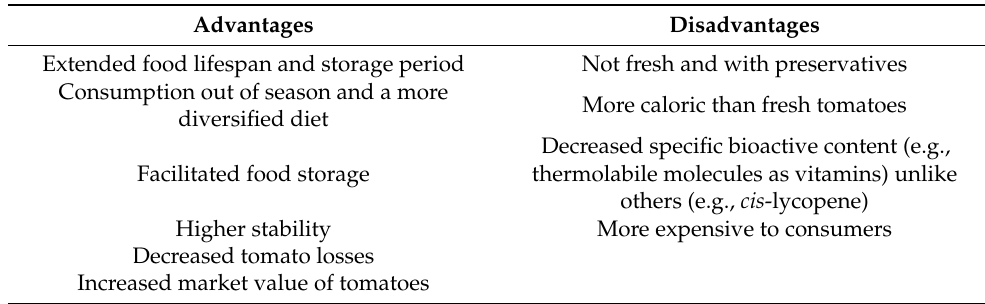
Table 1. Advantages and Disadvantages of tomatoes processing [18]. Advantages Disadvantages Extended food lifespan and storage